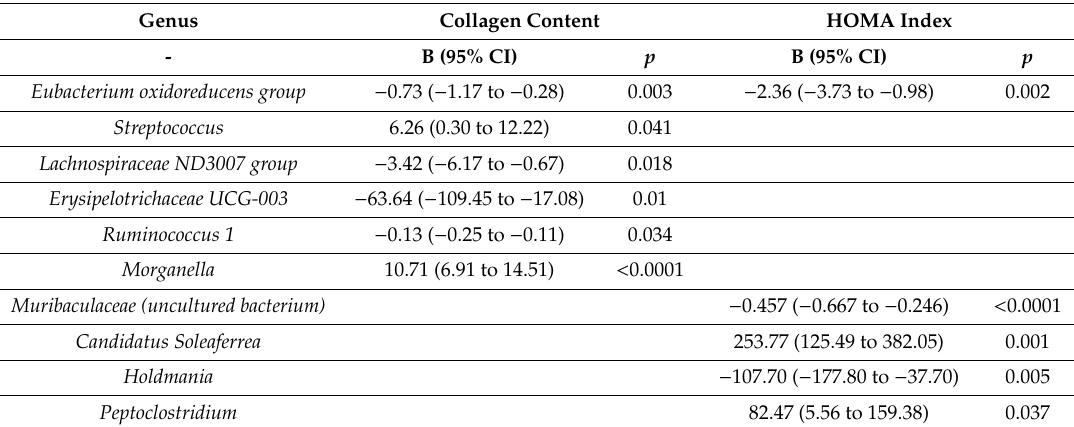
Table 3. Multivariate models for collagen content and Homeostasis Model Assessment (HOMA) index. Genus Collagen Content HOMA Index - B (95% CI) p B (95% CI) p Eubacterium oxidoreducens group − 0.73 ( − 1.17 to − 0.28)